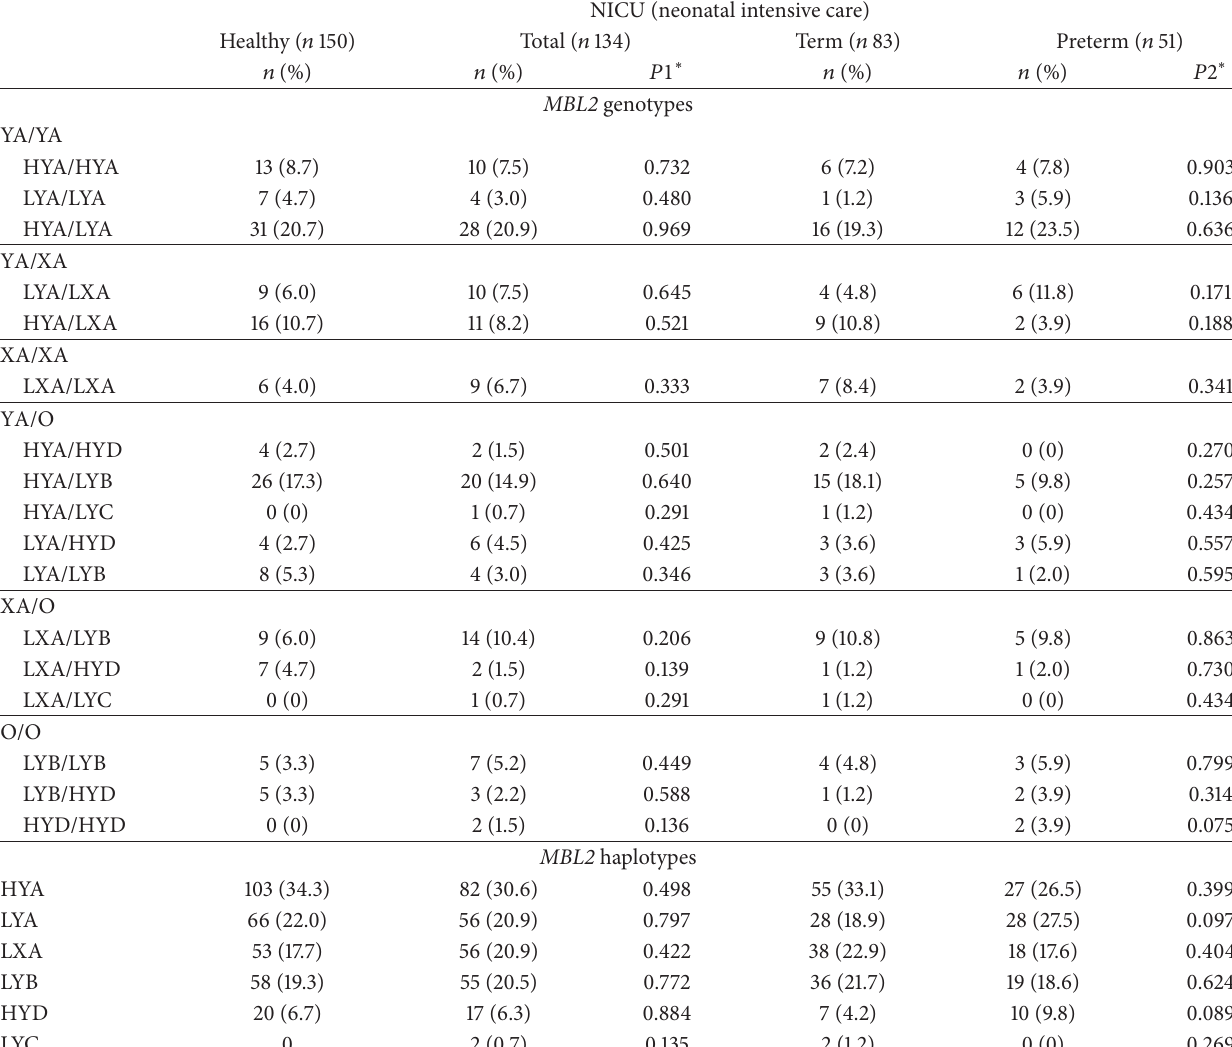
Table 3: Overview of MBL2 genotypes and haplotypes in the subjects of the